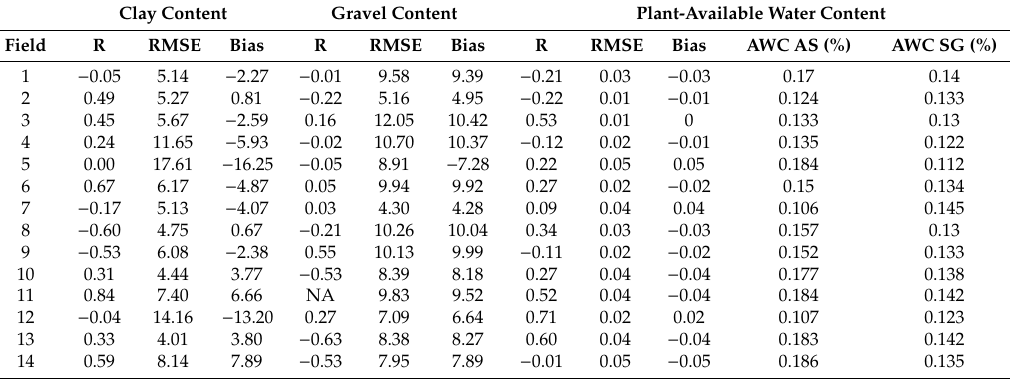
Table 2. Per-field results of comparison of measured soil texture data and texture data extracted from SoilGrids as well as plant-available water content derived from the HYPRES pedotransfer functions. R: Pearson correlation coe ffi cient, RMSE: root mean squared error, AS: analyzed soil texture, SG: SoilGrids-extracted soil texture, AWC: available water content. RMSE and bias in mass fraction in %. All values show mean values per field. Positive bias values indicate overestimation by SoilGrids. Clay Content Gravel Content Plant-Available Water Content